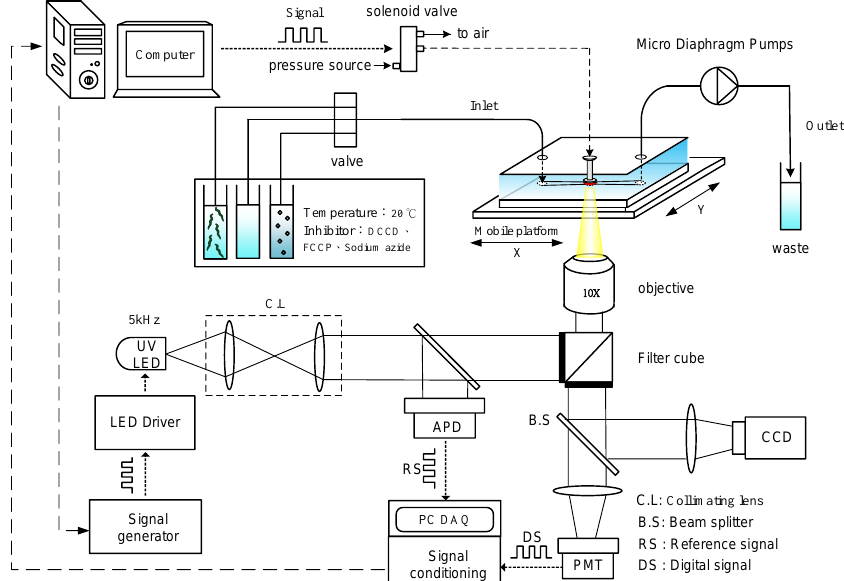
Figure 4. A schematic of the optical detection system, equipped with a UV LED as the light modulation source, to determine the OCR of a single C. elegans in real time via phase-based phosphorescence lifetime detection. The phosphorescence lifetime ( τ ) was calculated by measuring the phase shift ( θ ) between the modulated reference signal (RS) and the phosphorescence detected signal (DS) by using digital lock-in analysis. An air-pressure system was pneumatically driven to press the acrylic lid to seal the microwell. The aqueous solution of growth medium or specific metabolic inhibitors kept at 20 °C to treat a single C. elegans inside a microwell was introduced through the inlet of the microfluidic module at a specific point in time via a three-way valve. (C.L: collimating lens; B.S: beam splitter; APD: amplified